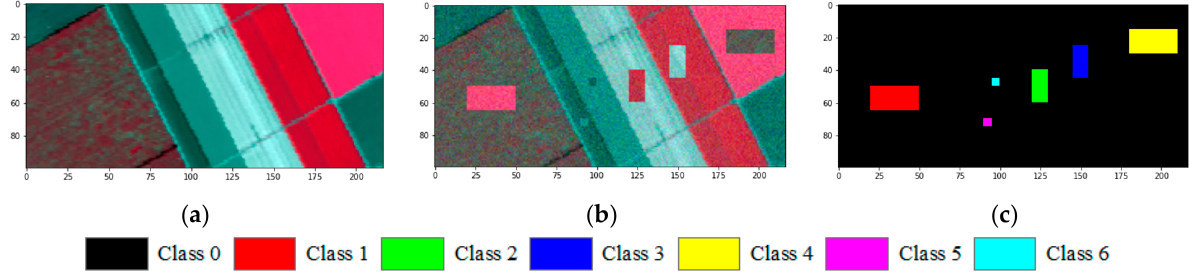
Figure 5. Simulated multitemporal image dataset: False-colour composite image (bands: R: 40, G: 30, B: 20): ( a ) Salinas original hyperspectral image; ( b ) simulated image with Gaussian white noise (mean = 0, variance = 0.001); and ( c ) reference image.